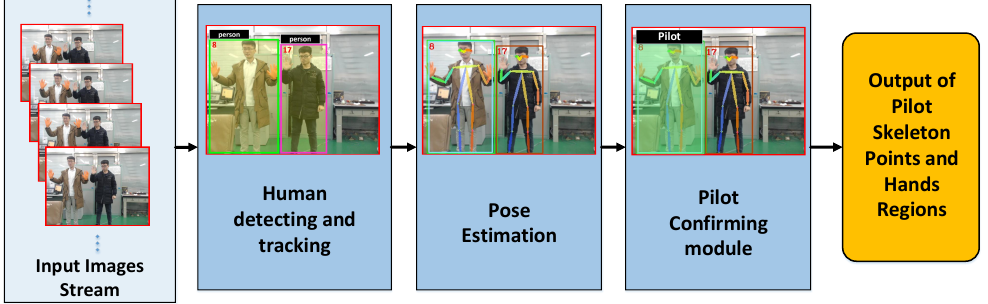
Figure 9. Diagram of pilot action detection module.